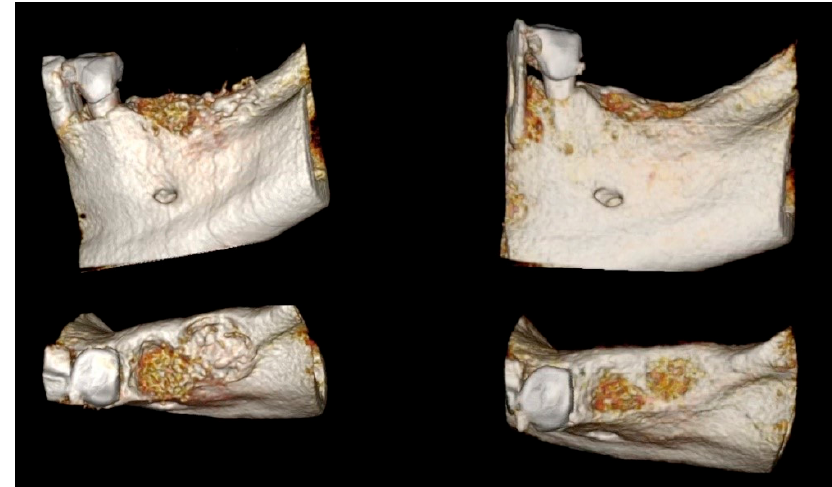
Figure 5. Three-dimensional rendering (OsiriX) in sagittal and axial views taken from CBCT ( left ) during postoperative period and ( right ) four months after the regenerative surgery.